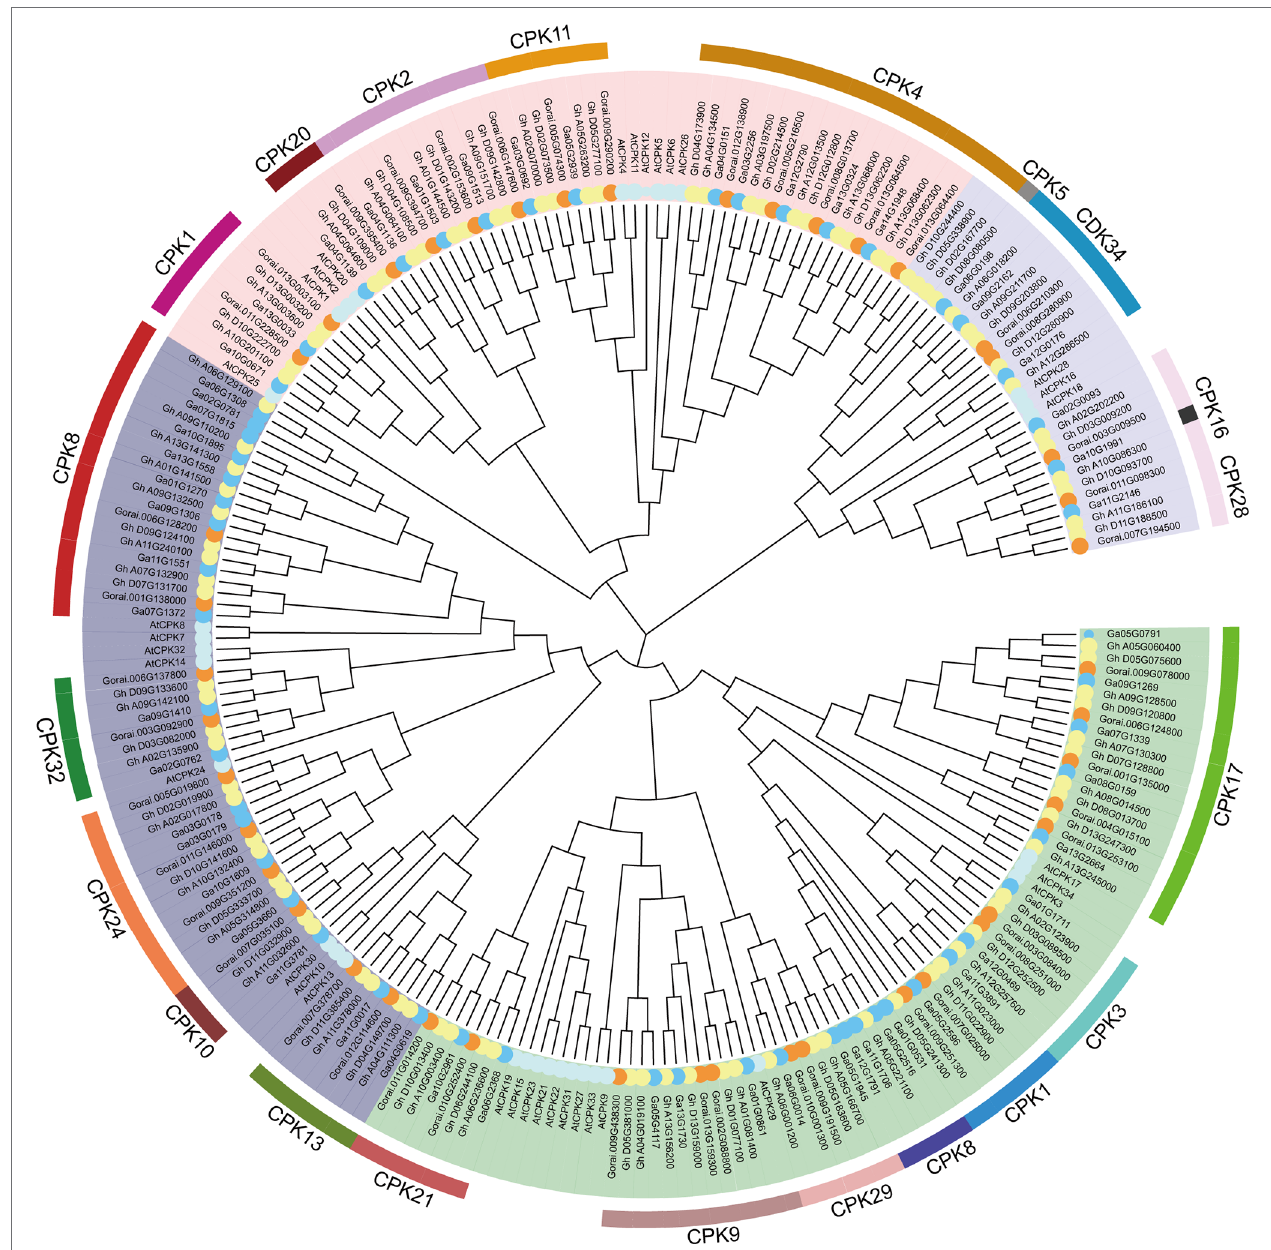
FIGURE 1 | Phylogenetic tree analysis phylogenetic tree. MEGAX software was used to construct the ML phylogenetic tree with the best substitution model. The Protein sequences of Arabidopsis thaliana (At), Gossypium hirsutum (Gh), Gossypium raimondii (Gr) and Gossypium arboretum (Gorai) were used. They are divided into four clades, clades I, II, III and VI are represented by green, deep purple, pink and light purple,